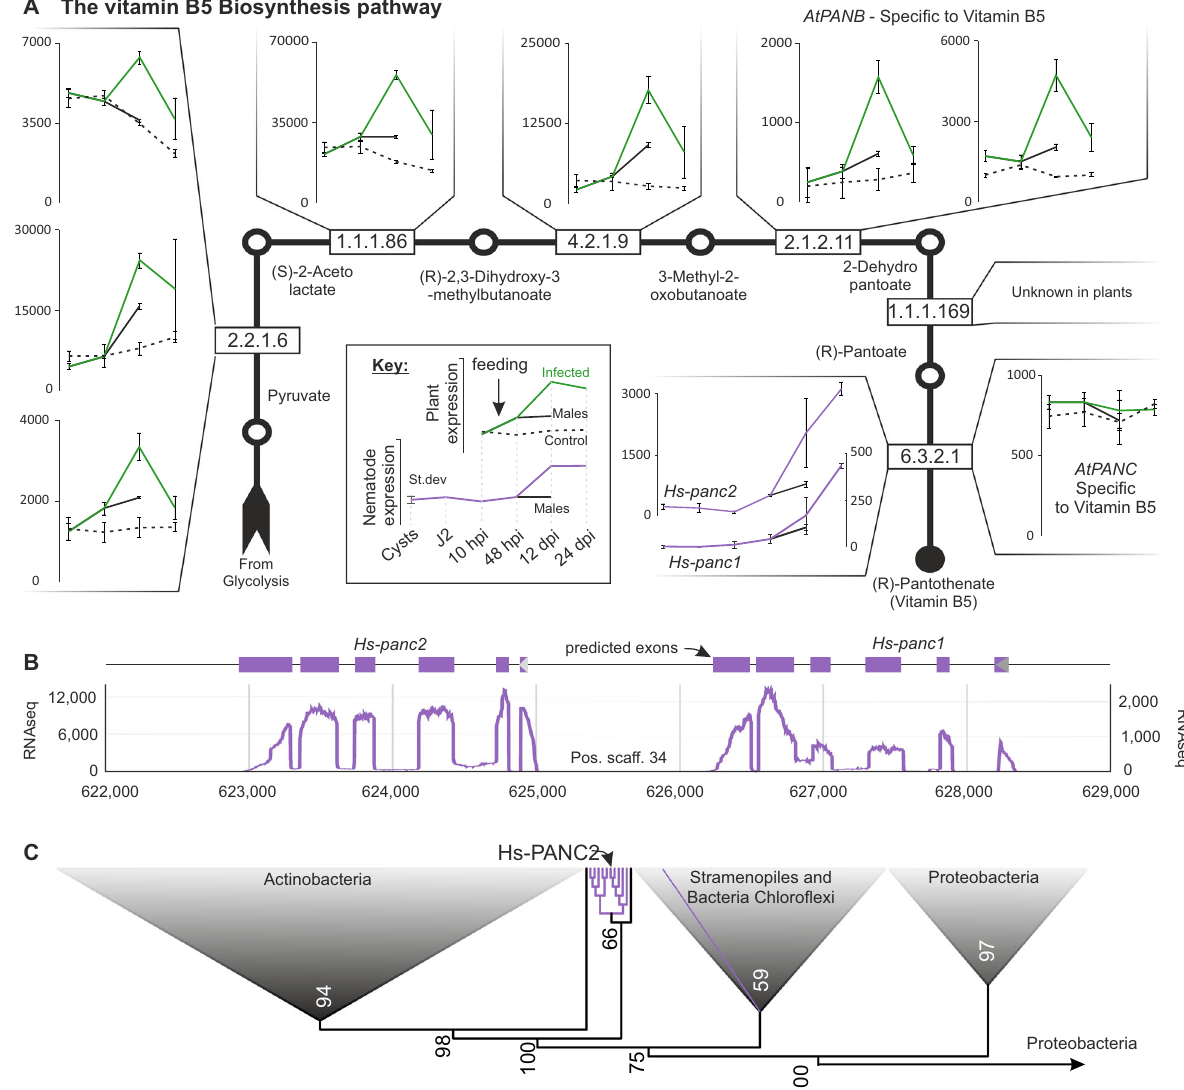
Fig. 6 | Congruent differential expression of the vitamin B5 biosynthesis pathway between kingdoms is enabled by a horizontal gene transfer from bacteria.A The linearpathwayof vitamin B5biosynthesis.Products/substratesare indicated with circles, enzymatic reactions (and corresponding Enzyme Commis- sion(EC)codes)withsquares.Foreachspecies,theexpressionpro fi lesofthegene/ s annotated with the EC codes at each step are shown (green for host, purple for parasite),ifpresent. Error bars indicate the standarddeviationof the mean (centre point, n =3 biologically independent samples). B The two predicted H. schachtii panc orthologues are adjacent, in the same orientation, and located towards the